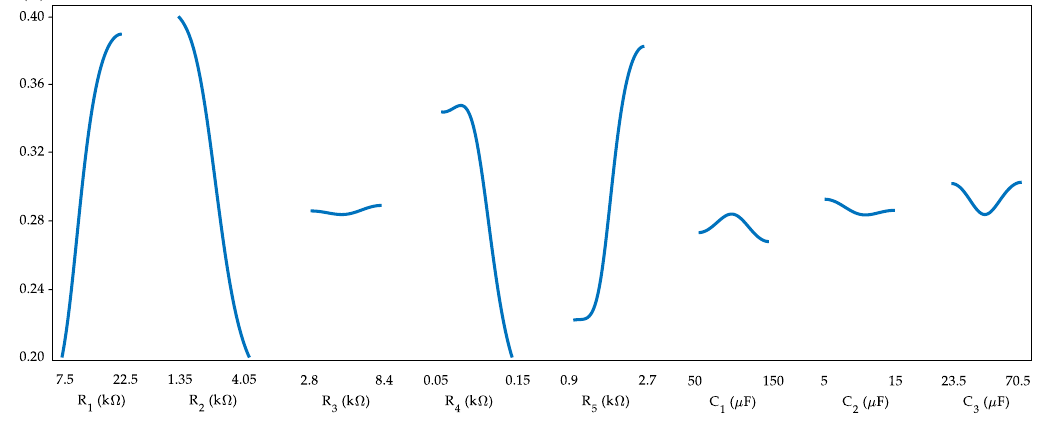
Figure 18. Main effects plot for THD using the FIS. Table 4. Predicted values using the tuned FIS obtained for both Av and THD.